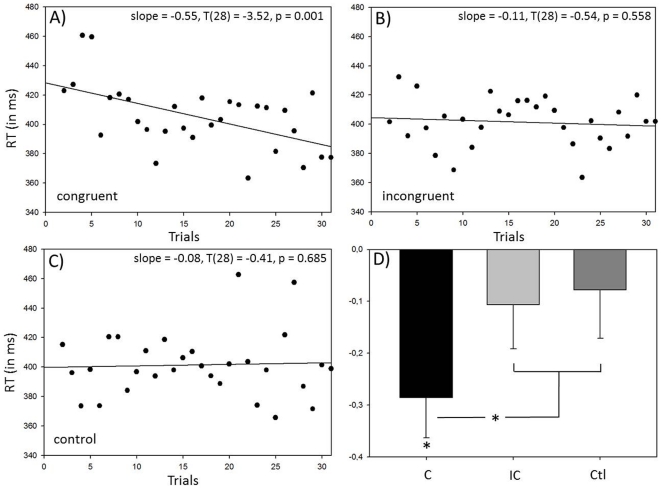
Regression-based analysis of the time-dependent cueing effect.A–C) For illustration of the time-dependent cueing effect, median RT across all subjects was calculated in a trial-by-trial manner, and simple regression slopes were fitted for each condition separately (with standardized slope β and the corresponding statistics of H0: β = 0 indicated in the upper right corner of each subplot). The slope in the congruent condition (A) reveals a significant acceleration of RT, based on slower responses at the beginning of the cueing experiment, which is not the case for the incongruent (B) and control (C) condition. D) Mean slope (+ SE) of regression coefficients of the different conditions. A significant difference (* p<.05) was found between the effect of the congruent and the combined effect of the incongruent and control condition (planned comparisons analysis). A significant deviation (* p<.05) from ß = 0 was only found for the congruent condition (one-sample t-test). C: congruent, IC: incongruent, Ctl: control.